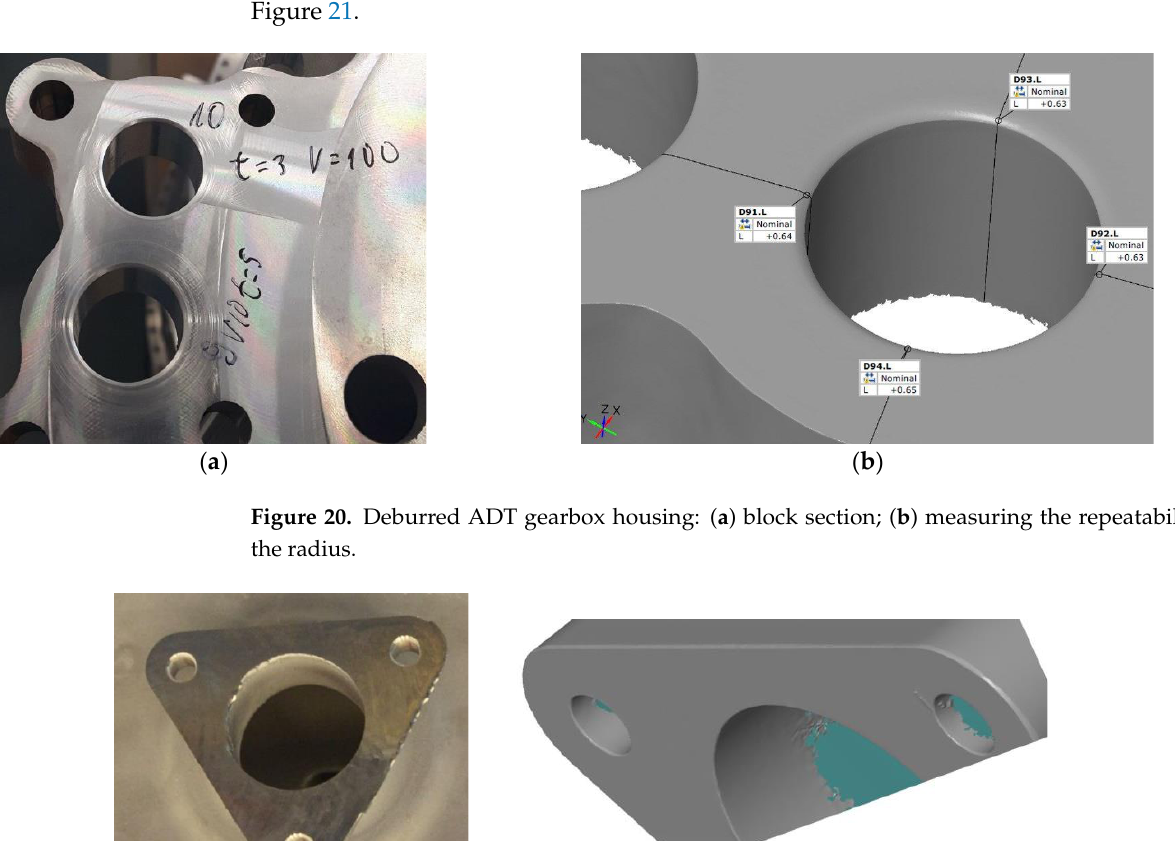
Figure 19. Results of the measurement of the blade in control sections.